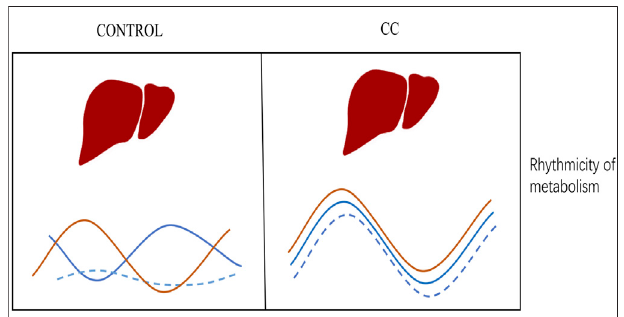
FIGURE 7 | Summary model encapsulates the most signi fi cant fi ndings. A schematic diagram may explain differences in gene rhythm expression caused by chronic cold conditions (see details in the